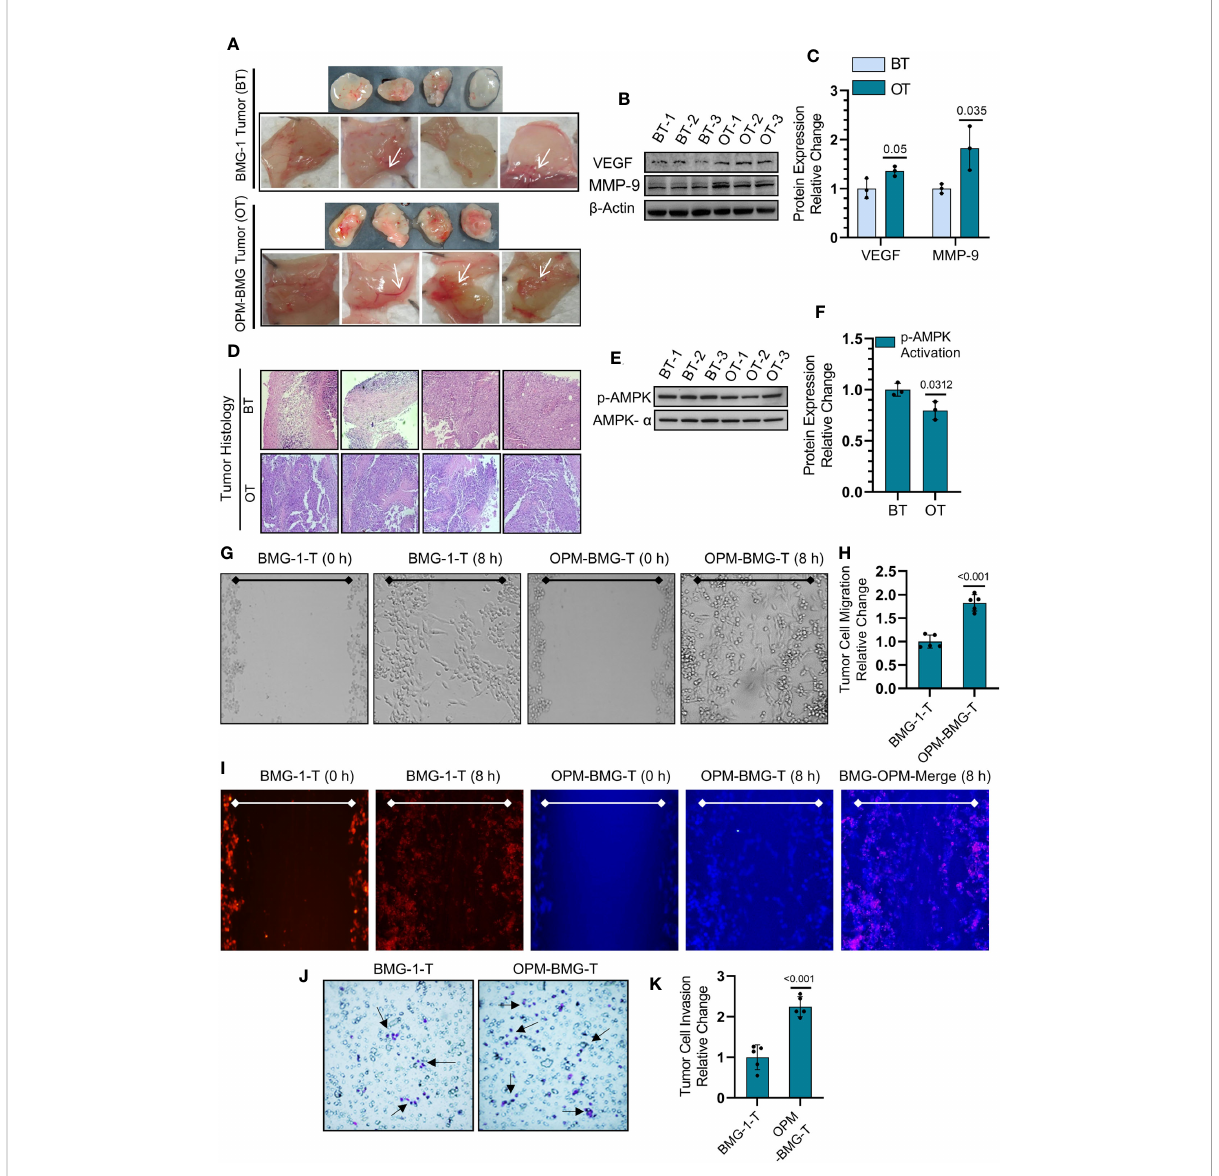
FIGURE 6 OPM-BMG tumors and derived cells showed aggressive tumor characteristics. (A) Photomicrographs of Matrigel plug depicting the angiogenesis in BMG-1 and OPM-BMG xenografted tumor (cell density 0.5×10 6 ) at 7 th -day post-implantation (n=4/group). (B, C) . Change in the expression level of proangiogenic proteins VEGF and MMP-9 (B) and presented as the relative change in the protein expression among BMG-1 tumor (BT) and OPM-BMG tumor (OT) samples (n=3 mice/group; (C) . (D) Histological examination of intra-tumoral compartments after H&E staining presented on the 25 th day of post-tumor implantation (n=4 mice/group). (E, F) . Metabolic energy stress marker proteins AMPK- a and its activated form p-AMPK- a were examined in BT and OT samples (n=3 mice/group; (E) and presented as the relative change in the indicated tumor samples (F) . (G, H) . Migration of tumor-derived cells, i.e., BMG-1-T & OPM-BMG-T, were monitored (after 8 h) in response to the mechanical scratch wound in unstained cells (n=5), followed by quantitative evaluation presented as relative change among the groups (H) . (I) Migration potential in BMG-1-T and OPM-BMG-T cells were examined in co-culture of separately stained cells using CTR (BMG-1-T cells) and CTB (OPM-BMG-T cells) fl uorescent probes, respectively (n=5). Differential images of cell movement were captured in the respective emission channel of probes, while merge staining is presented for better appreciation. J&K. Transwell invasion assay was performed by analyzing the differential chemotactic movement of BMG-1-T and OPM-BMG-T cells. In photomicrographs, arrows indicate the different stained cell populations in both groups (J) ; cells were further counted from fi ve random fi eld views and presented as relative change among the groups (K) . The bar plots are the mean ± SD; P -values (BMG-1 versus OPM-BMG tumor samples) are mentioned in the